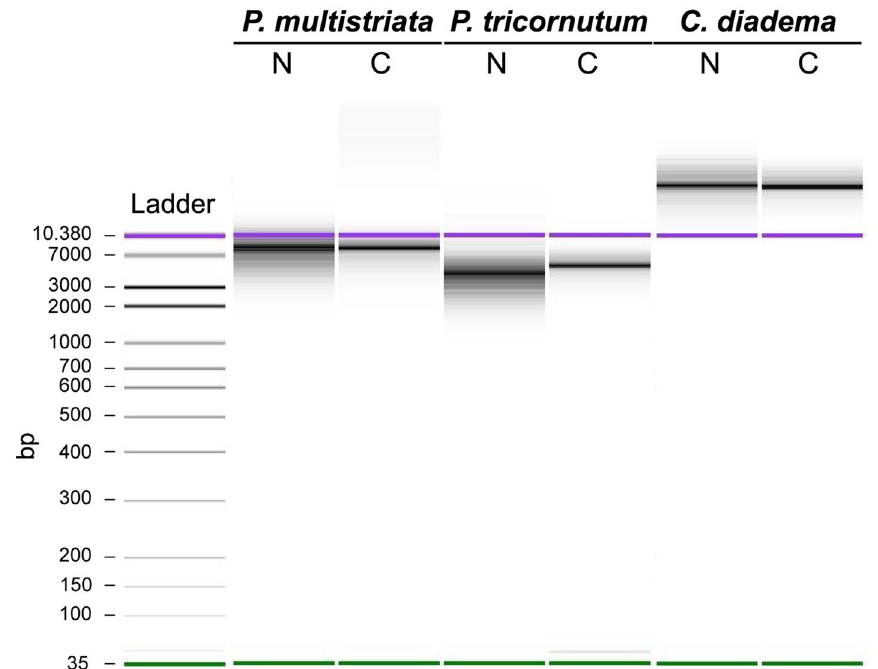
Figure 4. Quality control of genomic DNA extracted from P. multistriata , P. tricornutum , and C. diadema . High sensitivity DNA electrophoresis (Agilent 2100 Bioanalyzer System) of gDNAs extracted from intact cells and isolated nuclei from P. multistriata , P. tricornutum and C. diadema . N (nuclei), C (cells), bp (base pairs). In purple and green the higher and the lower bands of the DNA-ladder used as